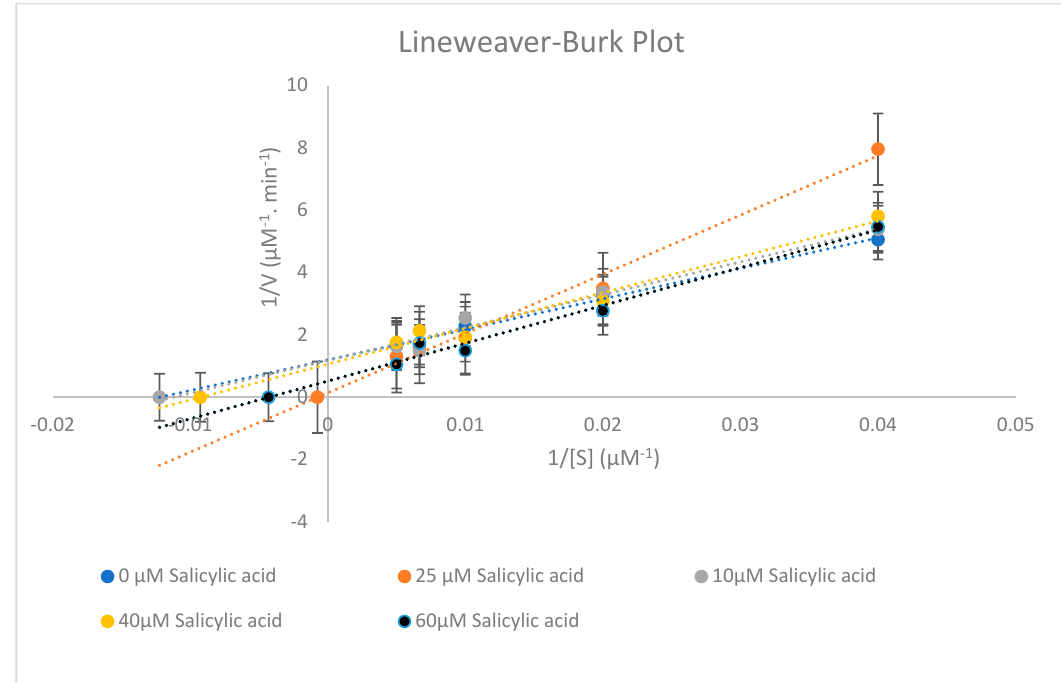
Figure 4. Representative Lineweaver–Burk plot for the inhibition of CYP2E1-catalysed chlorzoxazone 6-hydroxylation (chlorzoxazone (25–200 µM)) with 0, 10, 25, 40, and 60 µ M salicylic acid. Each point represents the average of three determinations.